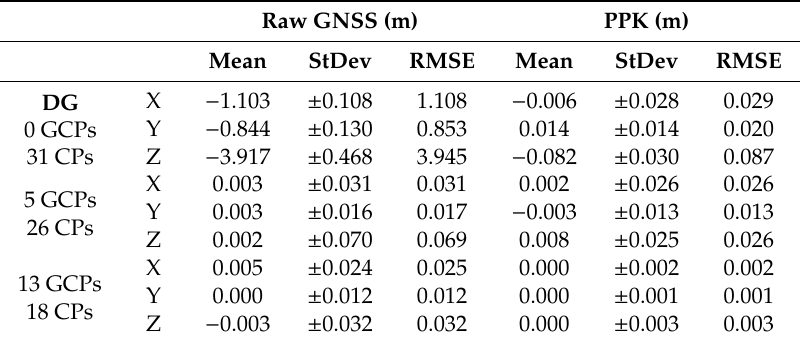
Table 1. Positional accuracy of the di ff erent direct georeferencing strategies tested with the eBee Plus at the site of Accumoli, from